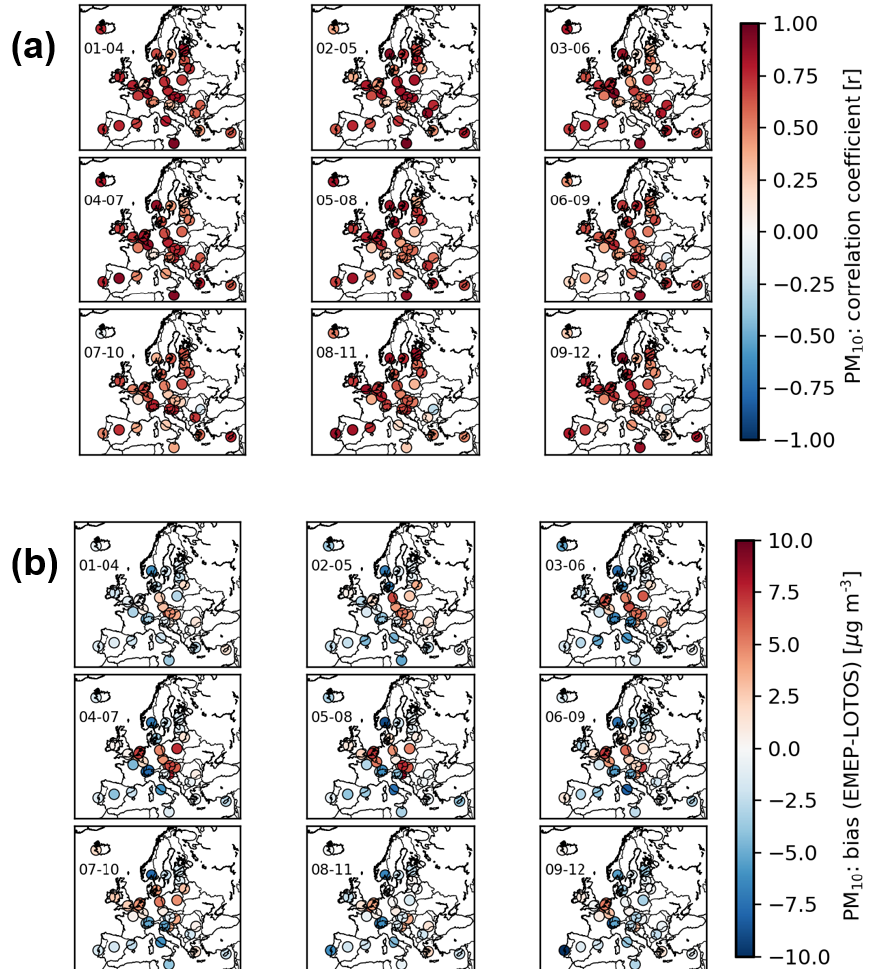
Figure 5. (a) Correlation coefficient and (b) bias in the predicted PM 10 concentrations between the EMEP model and LOTOS-EUROS over all of the studied cities using the nine grid cells definition for each 4d forecast (1–4, 2–5, 3–6, 4–7, 5–8, 6–9, 7–10, 8–11, and 9– 12 December